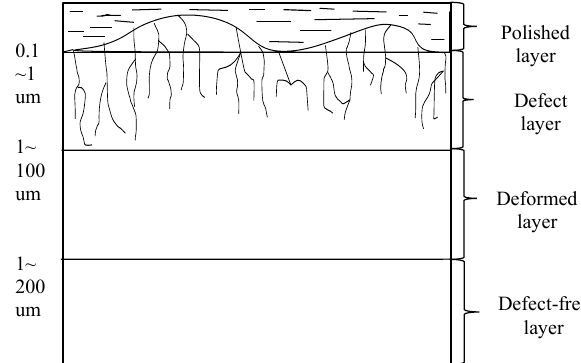
Fig . 1 . Schematic view of the subsurface damage in brittal